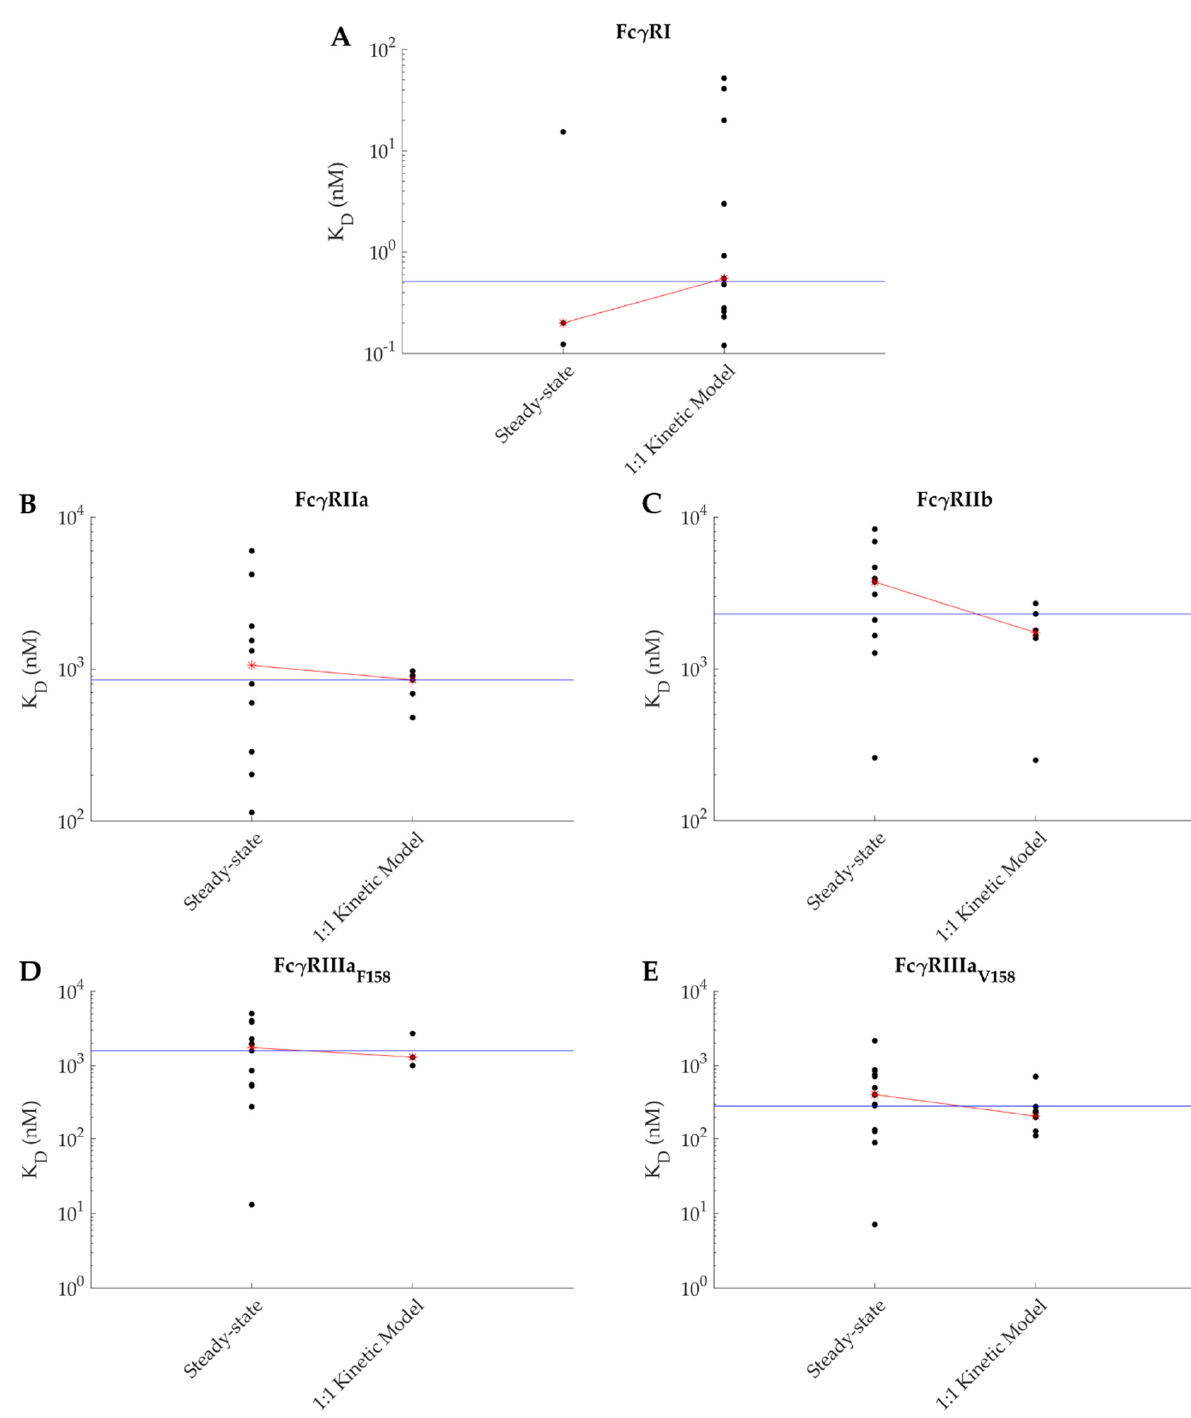
Figure 3. Affinities reported in the literature between IgG and ( A ) FcgRI, ( B ) FcgRIIa, ( C ) FcgRIIb, ( D ) FcgRIIIa F158, and ( E ) FcgRIIIa V158 depending on the analysis model (steady-state or 1:1 Langmuir kinetic model). The blue line represents the median of all values combined, while the red line crosses the median point values specific to each analysis model.